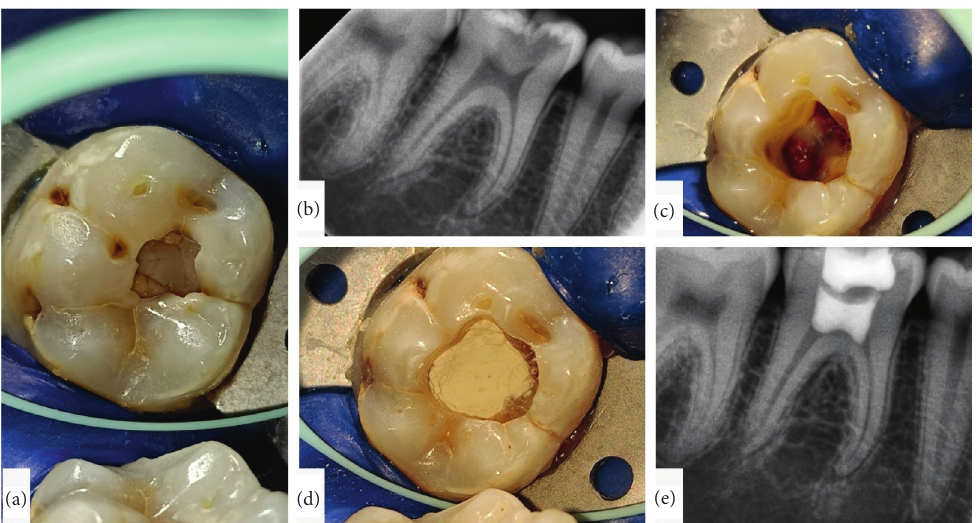
Figure 2: Stepwise procedure of pulpotomy. Step a, preoperative picture of the affected tooth. Step b, preoperative radiograph of the tooth. Step c, removal of the affected coronal pulp and leaving the radicular pulp intact. Step d, placement of MTA. Step e, postoperative radiograph.